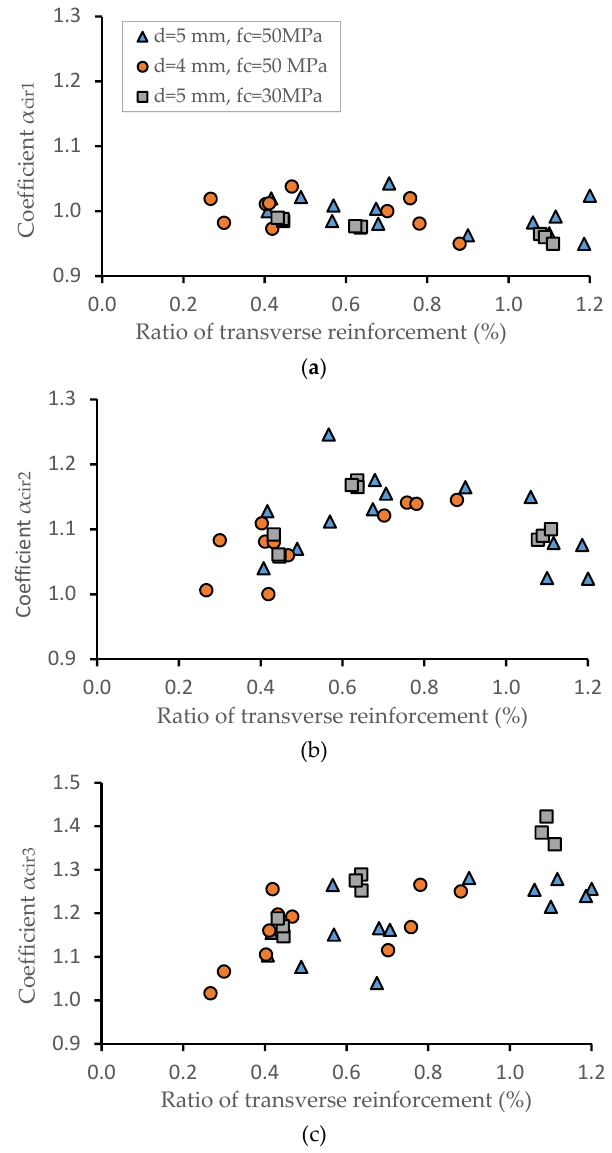
Figure 4. Coefficients α cir 1 (a), α cir 2 (b), α cir 3 (c) dependence on the ratio of transverse reinforcement 296 Figure 4. Coe ffi cients α cir 1 ( a ), α cir 2 ( b ), α cir 3 ( c ) dependence on the ratio of transverse reinforcement (when the coefficient of longitudinal reinforcement equal zero). 297 (when the coe ffi cient of longitudinal reinforcement equal